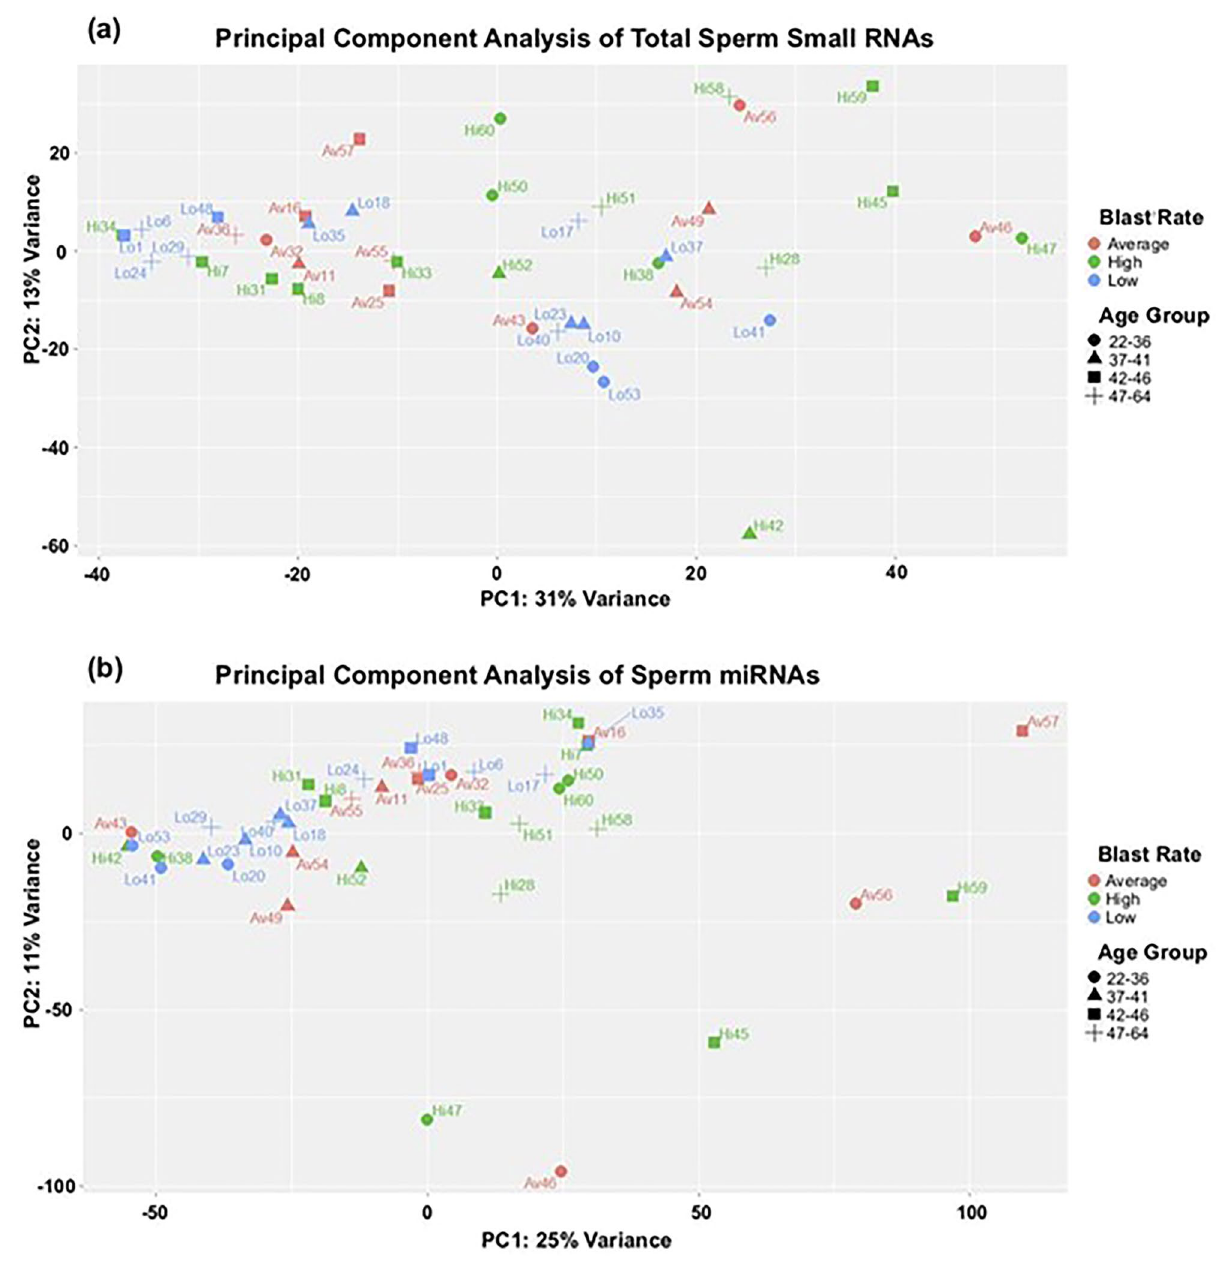
Figure 2. Principal Component Analysis. (a) Total small RNAs. The variation values of PC1 and PC2 are 31% and 13%, respectively. Plotted data points represent individual samples, which are labeled and coloured based on relative blastocyst rate. The age group of each sample is also depicted using shapes. (b) Human miRNA-only dataset. The values of PC1 and PC2 are 25% and 11%, respectively, and samples are represented in the same manner as ( a